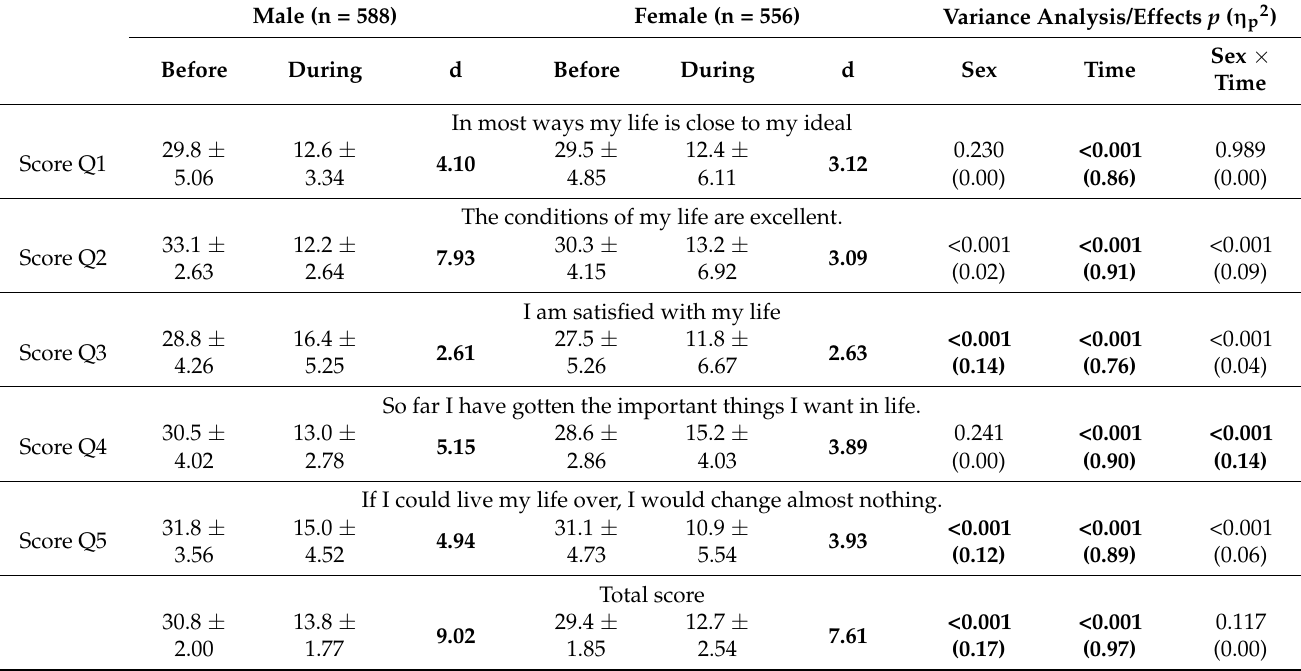
Table 4. Comparison of “satisfaction with life” parameters depending on sex before and during confinement. Values are given as mean ± SD. Significant effects (criteria of relevance: p < 0.05 and η p2 > 0.10 and d > 0.8) highlighted in bold. Male (n = 588) Female (n = 556) Variance Analysis/Effects p ( η p2 )